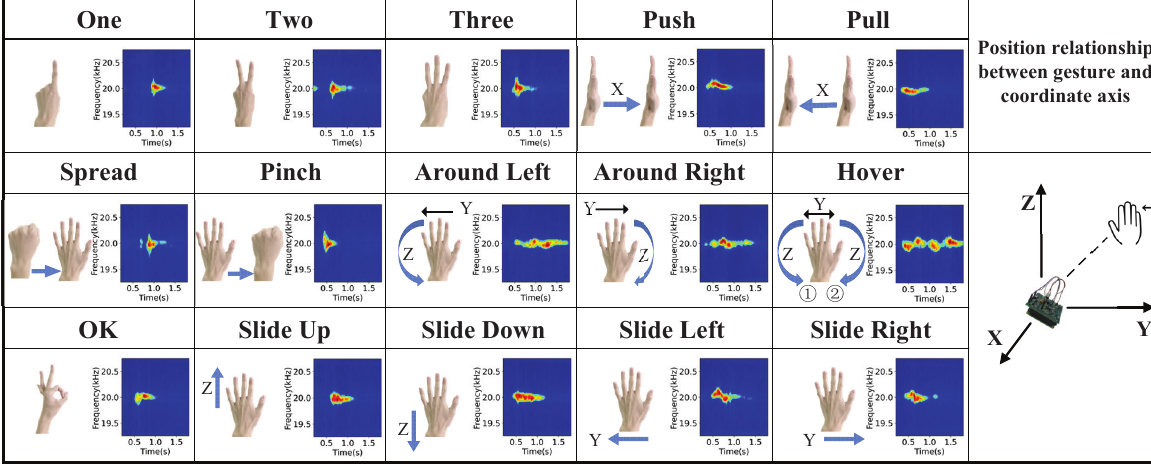
Figure 2. Single gesture spectrogram.